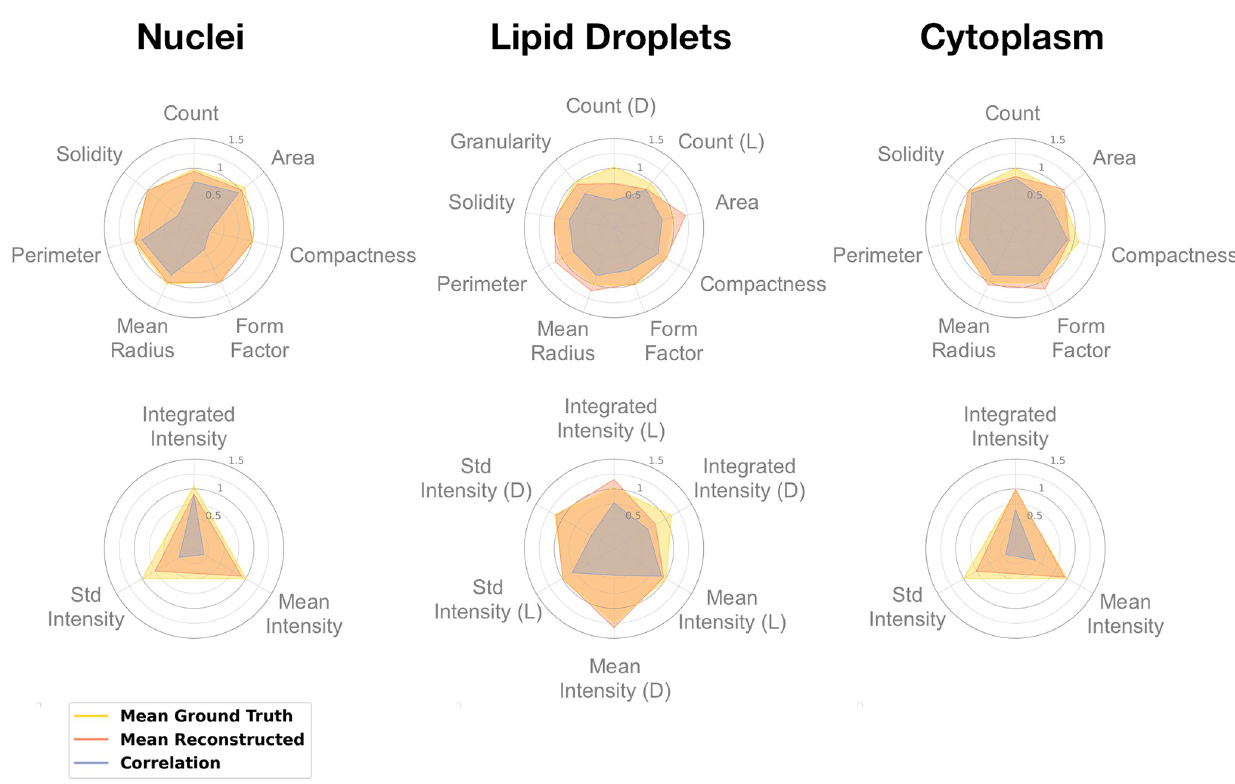
Fig 8. Individual feature scores for the models evaluated on the test set. The plots shows the mean of each feature across the images and display the results for both the generated and ground truth fluorescence images. The plots also include the Spearman correlation for each feature. Top row represents morphology and count features and bottom row shows intensity features. For the lipids: (D) lipids with defects; and (L) all lipid droplets.